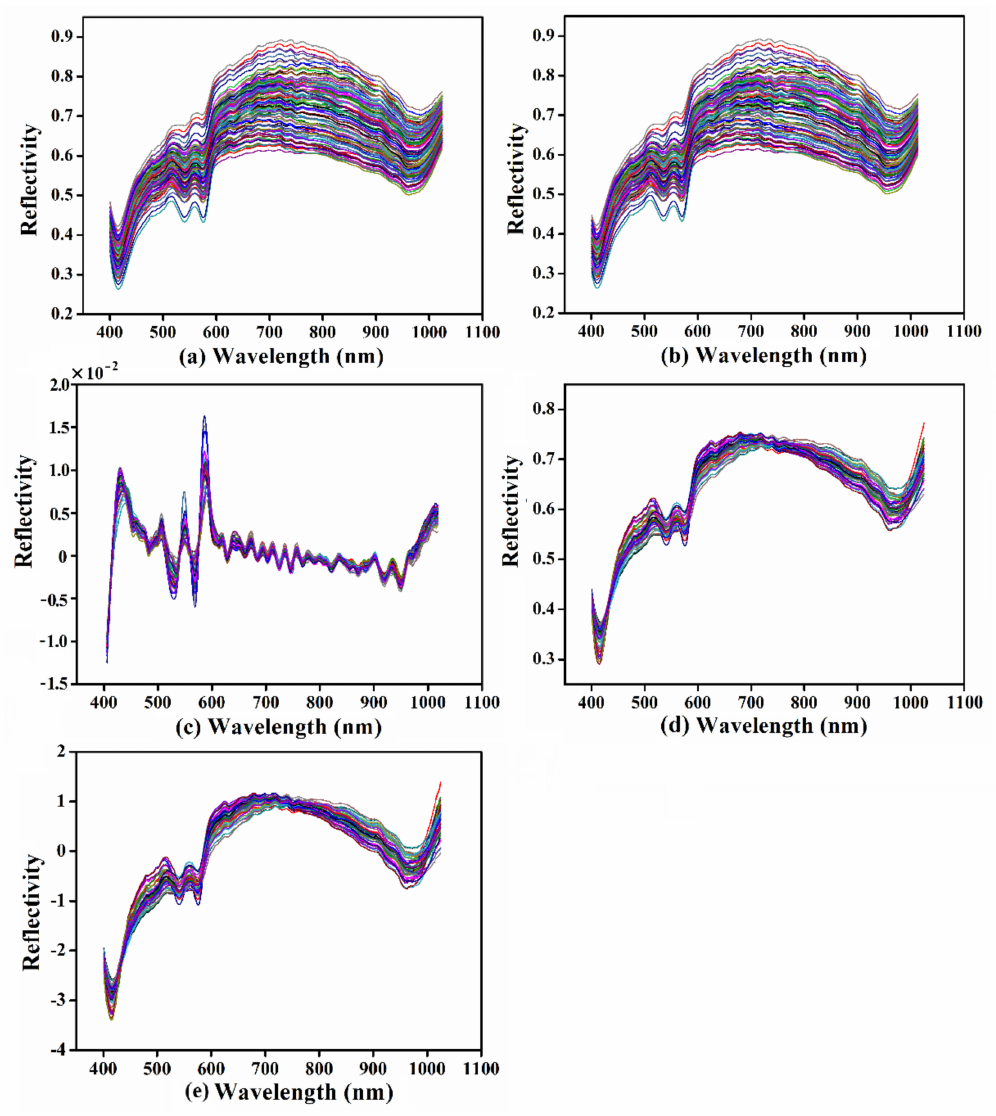
Figure 4. Mean spectra of carp with di ff erent preprocessing methods: ( a ) original mean spectra; ( b ) mean spectra preprocessed by SG; ( c ) mean spectra preprocessed by FD; ( d ) mean spectra preprocessed by MSC; and ( e ) mean spectra preprocessed by